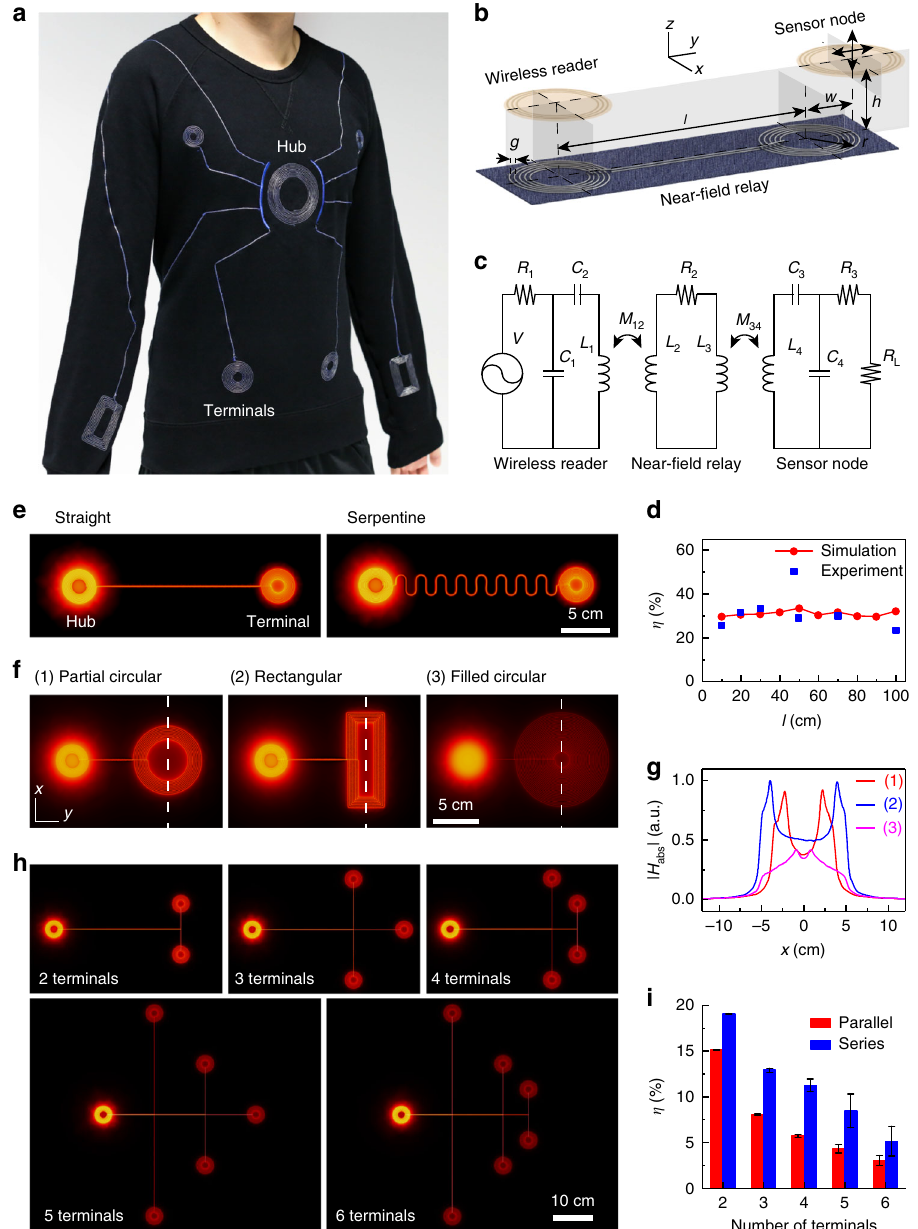
Fig. 2 Near- fi eld-enabled clothing design and characterisation. a Photograph of near- fi eld-enabled long-sleeved shirt comprised of a network with a single hub and eight terminals. b Con fi guration of the near- fi eld relay when interconnecting a wireless reader with a sensor node. c Circuit model of the relay system in b . d Power transfer ef fi ciency η as a function of relay length l . The geometrical parameters are r = 1.7 cm, N = 10, g = 0.1 cm, h = 1 cm, and w = 0 cm. e Normalised magnetic fi eld amplitude ∣ H abs ∣ above relays with straight and serpentine interconnects. f Magnetic fi eld generated by designs (1) partial circular (7.2 cm diameter), (2) rectangular (10 cm length, 4 cm width) and (3) fi lled circular (10 cm diameter, 70% area fi lling ratio). Designs (1) and (2) have a area fi lling ratio of ~38%. g Magnetic fi eld pro fi les along the dashed white lines in f . h Magnetic fi eld above relays with multiple terminals connected in parallel. l = 30 cm between the hub and each terminal. i Power transfer ef fi ciency η as a function of the total number of terminals connected either in parallel or in series. Error bars show mean ± s.d. ( n = number of